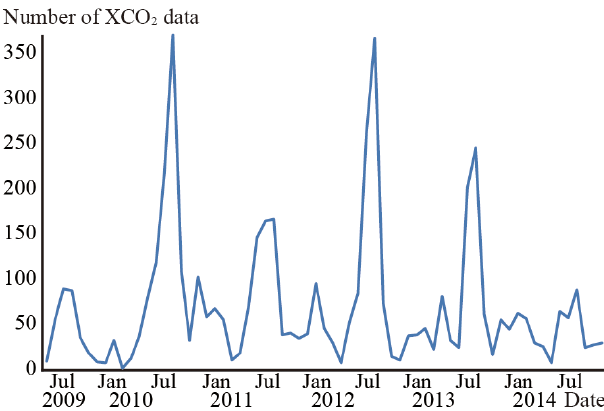
Figure 1. Monthly changes in the number of FTS L2 XCO 2 data in the Amazon. The five-point cross-track scan mode was used until 1 August 2010, when it was replaced with the three-point cross- track scan mode. Therefore the numbers themselves before and after 1 August 2010 cannot be compared.